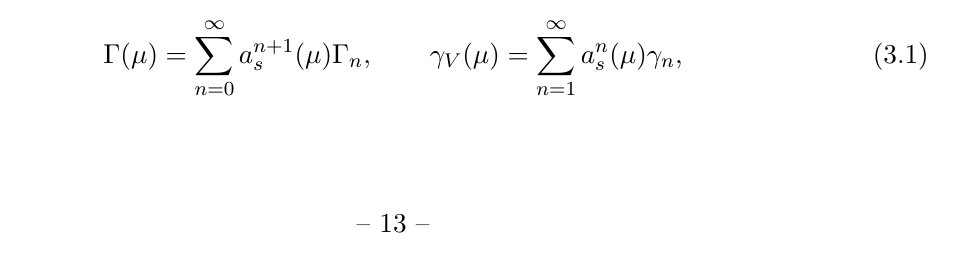
Figure 3 . Comparisons of di(cid:11)erent solution for ln R (( M Z ; M 2 The blue line is the solution 1. The red Line is the solution 2. The green line is the solution 3. The error band is obtained from the improved D solution at (cid:22) 0 = (cid:22) i by variation of (cid:22) 0 2 (0 : 5 ; 2) (cid:22) i . The blue line with error-band corresponds to the solution used in